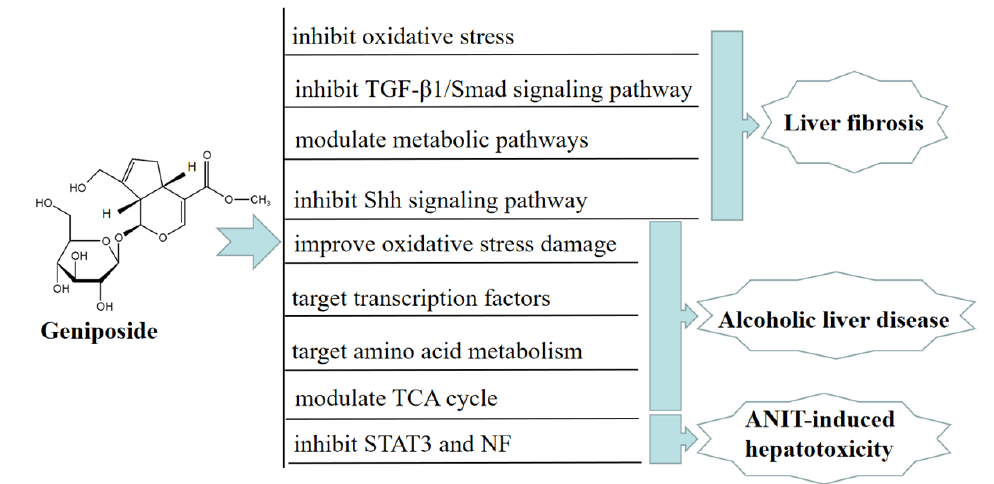
Figure 2. A summary of mechanisms of geniposide on liver injury disease.